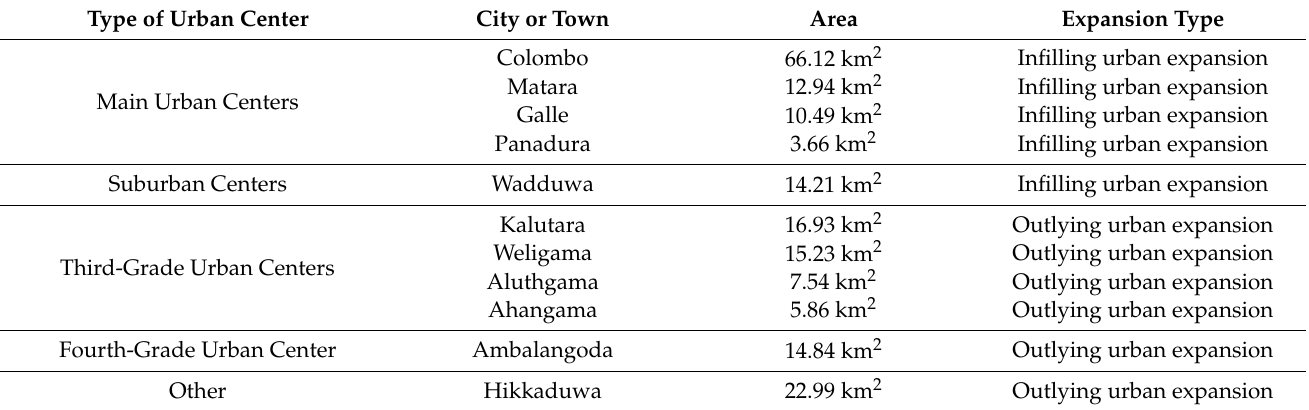
Figure 7. Composite map of urban function-related parameters. Table 8. Identified urban centers and expansion types of adjacent urban